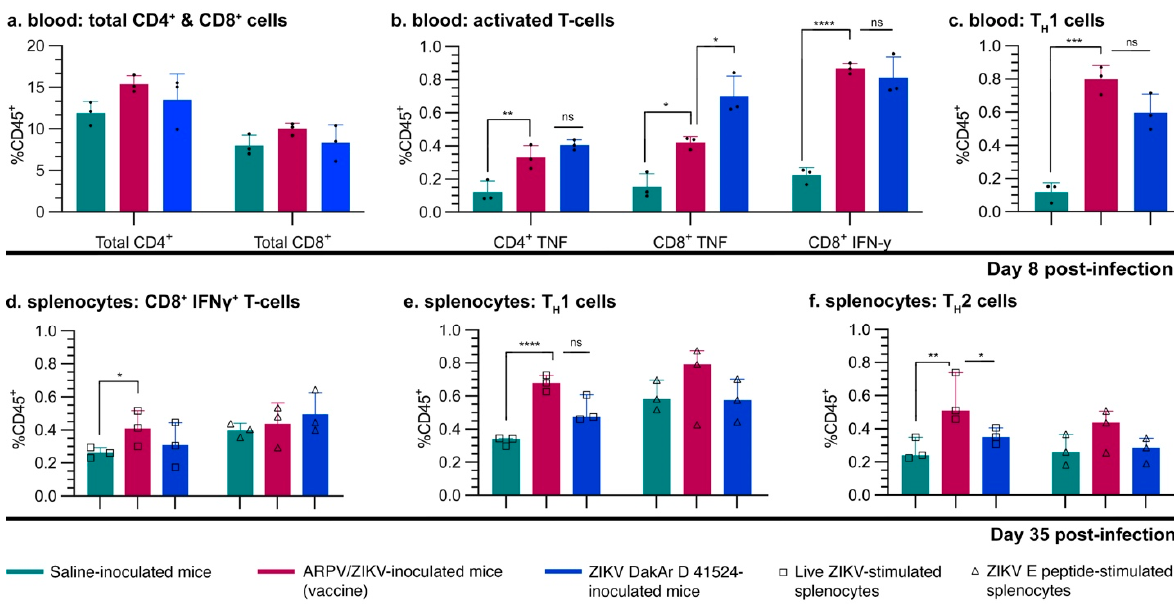
Figure 7. ARPV/ZIKV vaccination induces a robust T-cell-mediated immune response in immune-competent mice. Four- week-old C57BL/6 mice were inoculated s.c. with either saline, ARPV/ZIKV, or ZIKV. Splenocytes were harvested from animals (n = 3) at either 8 days post-infection (dpi) or 35 dpi and cultured in triplicate for in vitro stimulation with either live ZIKV (squares) or ZIKV E peptide mix (triangles). ( a – c ) Blood samples were also taken at 8 dpi and were stained ex vivo to substantiate in vitro findings. Blood samples from ARPV/ZIKV-vaccinated mice showed increases in activated CD4 + or CD8 + T cells and CD4 + T H 1 subset cells. ( d – f ) Cultured splenocytes harvested 35 dpi and stimulated in vitro were differentiated by ICS and flow cytometry. Stimulated splenocytes derived from ARPV/ZIKV-vaccinated mice showed increases in T-cell populations of ( d ) activated CD8 + IFN γ + T cells, ( e ) CD4 + T H 1 subset cells and ( f ) CD4 + T H 2 subset cells. Significance was determined by one-way ANOVA ( a – c ) or two-way ANOVA ( d – f ). Columns indicate mean values and error bars indicate SD of the mean. Circles represent individual mouse data points. Unless otherwise marked, asterisks indicate significance compared to saline-inoculated negative controls: not significant (ns), p ≤ 0.033 (*), p ≤ 0.002 (**), p ≤ 0.0002 (***) and p ≤ 0.0001 (****).